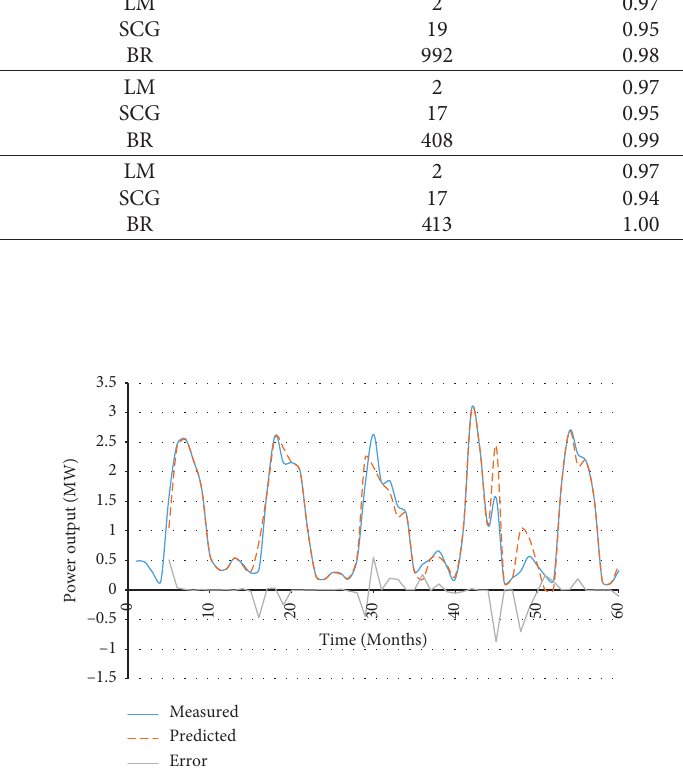
Figure 8: The error between predicted and actual power levels for LM algorithm with a validation percentage of